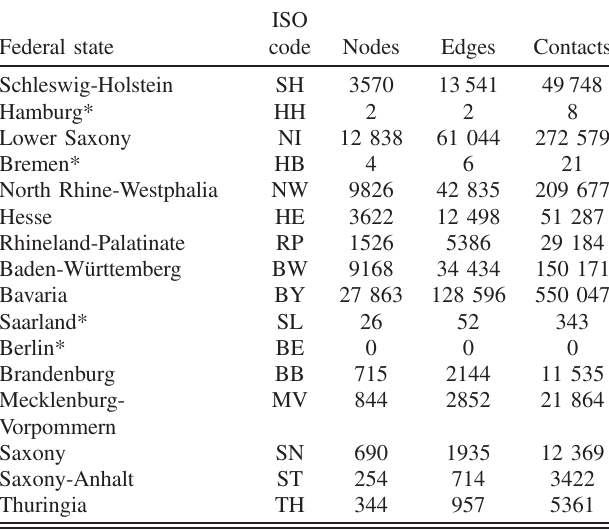
TABLE I. Federal states of Germany and the corresponding abbreviation, together with basic network statistics: number of nodes, number of (static) edges, and number of (temporal) contacts. In all cases, we confined the network to the GSCC. We mark the smallest networks, i.e., the city states Berlin, Hamburg, and Bremen, as well as Saarland, with an